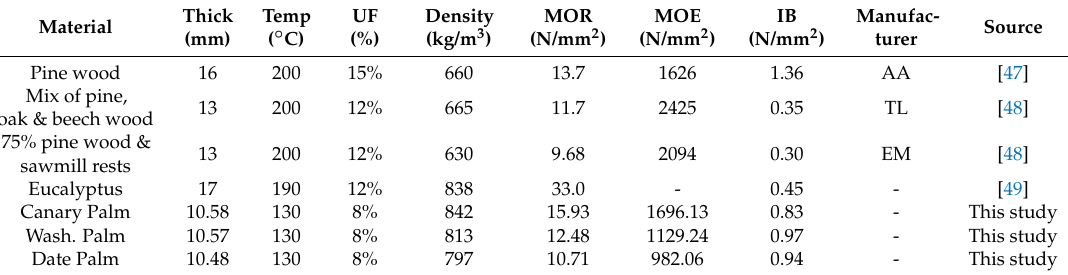
Table 5. Average properties of commercial particleboards tested by different